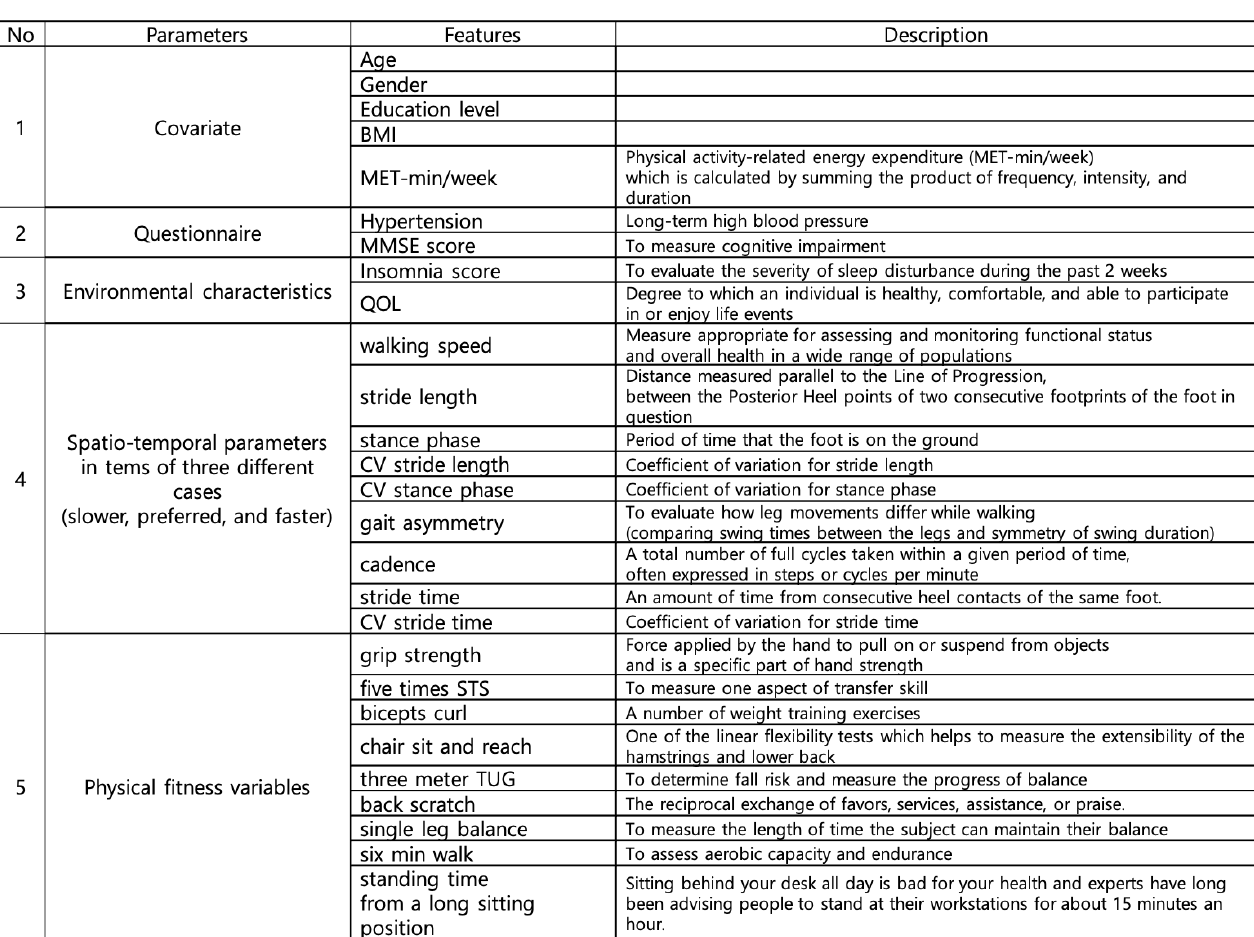
Figure 3. Walking-related features extracted by the non-invasive method.